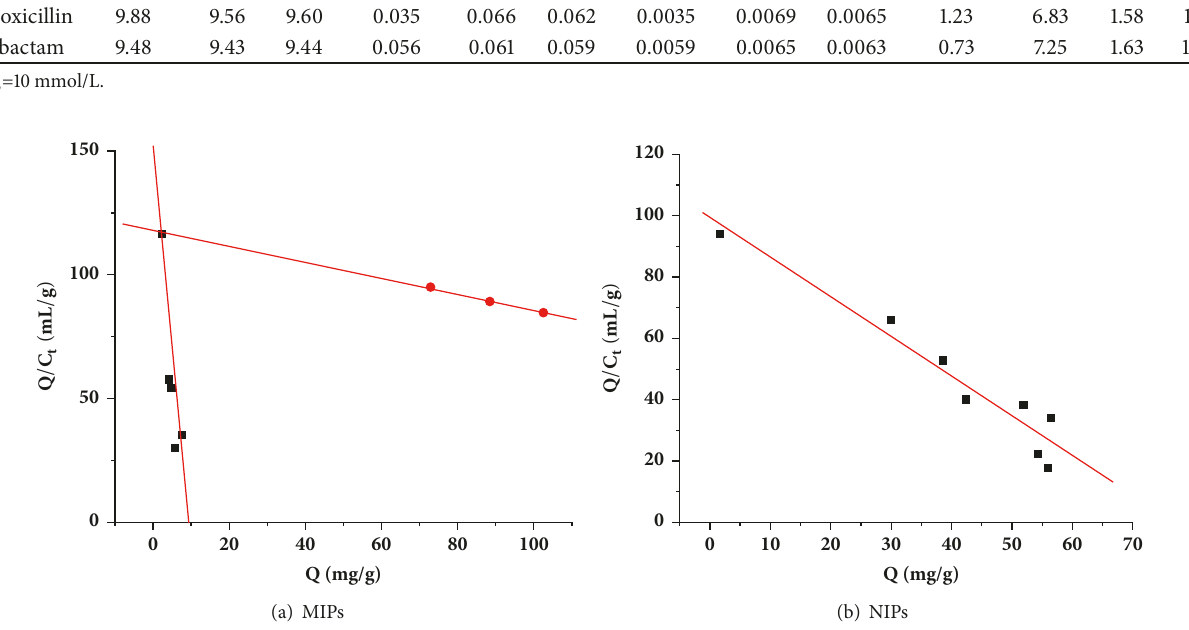
Figure 6: Scatchard fitting curves for (a) MIPs and (b) NIPs microspheres.